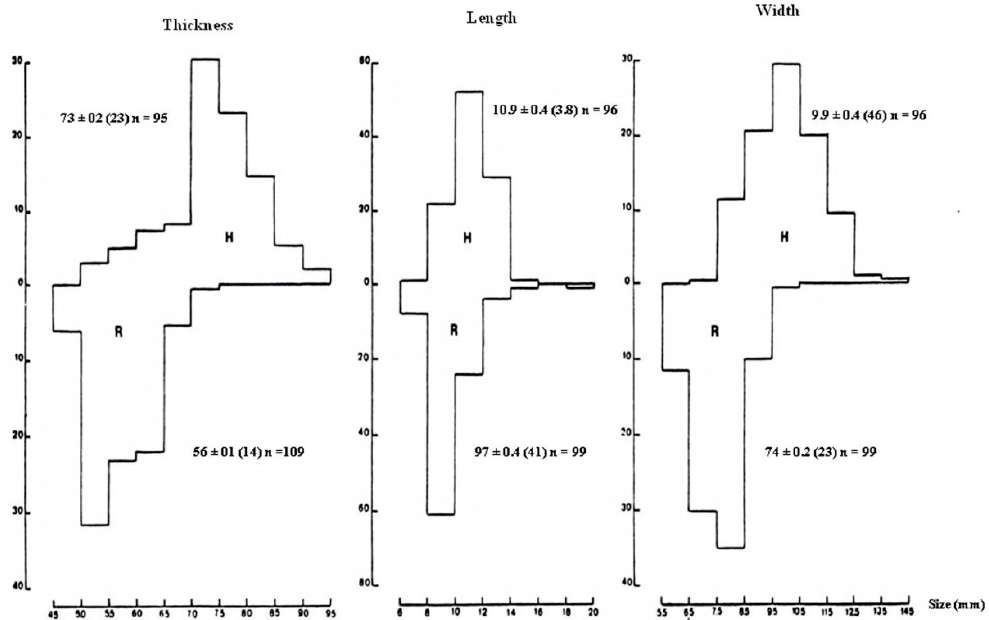
Figure 2. Frequency histograms of Iberian hare (above, H) and European rabbit (below, R) pellet dimensions from samples collected in rabbit warrens (January 1984 and hare bedding sites (October 1983). The mean ± SE, 95%, confidence intervals, and sample sizes are indicated.